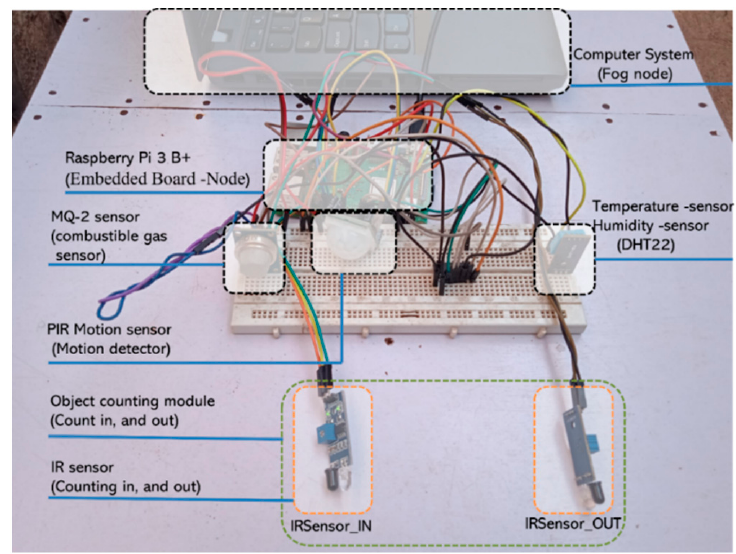
Figure 9. Detailed mounted sensor node with all related components.